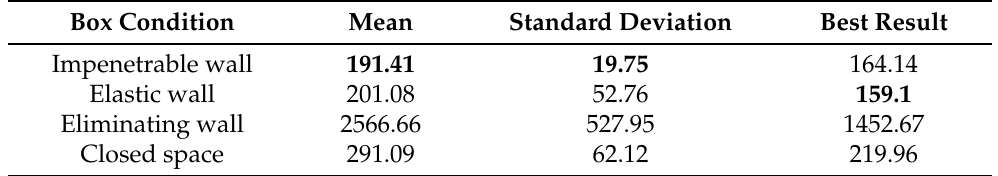
Table 1. Comparison of the results with the four feasibility function tested. The results are obtained with 12 independent trials and with 50,000 objective function calls. In bold the best